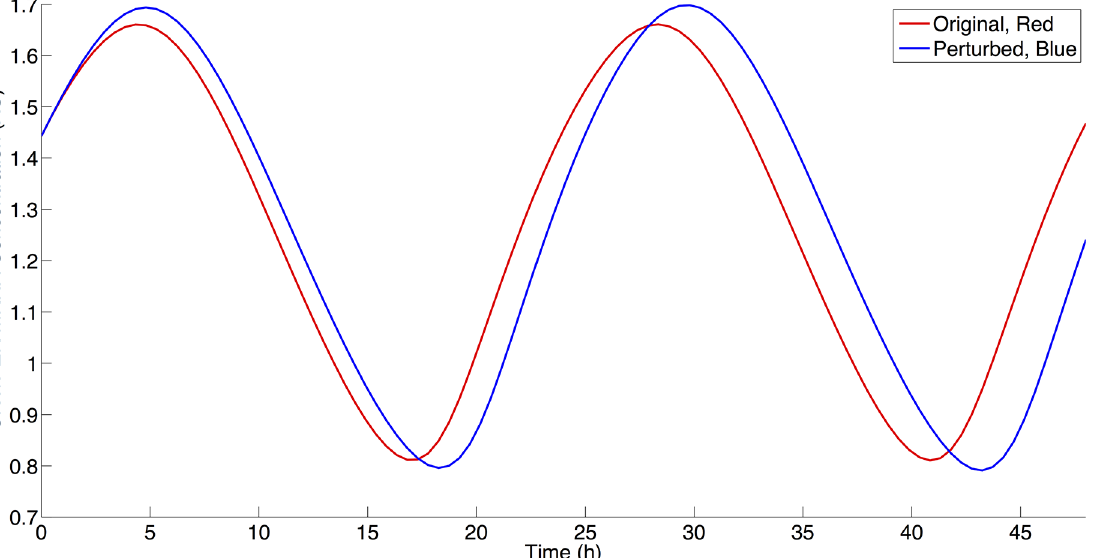
Fig 8. The effect of SIRT1 inhibition on histone components on CRY/PER mRNA levels. Red: Simulation using parameter values from Table 2. Blue: Simulation using parameter values from Table 2 with a 25% decrease in VSIRT1d value. doi:10.1371/journal.pcbi.1004144.g008 Fig. 7. Similar to Nakahata et al., a decrease in VSIRT1d results in an increase of CRY/PER mRNA levels, as shown in Fig. 8, due to a smaller repressive effect by SIRT1 on transcription [15,16]. Fig. 9 shows the percentage change in maximal levels of CRY/PER mRNA levels over the parameter values that exhibit stable oscillations for the SIRT1-related parameter values. We find these results to be robust by reducing each of these three parameters to 30% of the original